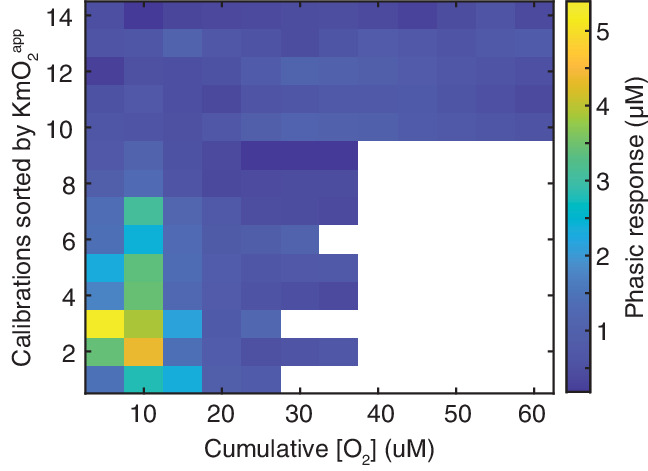
Phasic biosensor responses to O2in vitro.Amplitude of phasic response (color) as a function of cumulative O2 after each addition, sorted by sensor’s tonic KmO2app. Amplitudes were calculated as Ch concentration, based on sensors’ response to 5 μM Ch.